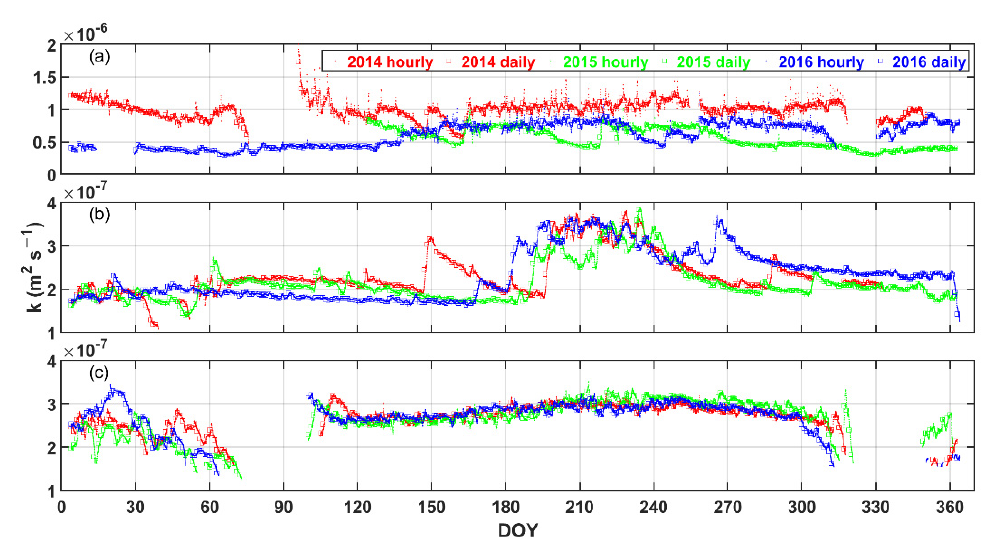
Figure 4. The variations of hourly (marked with dot) and daily (marked with square) soil apparent thermal diffusivity (k, m 2 s − 1 ) of the 0.0 m to 0.20 m layer at ( a ) BJ, ( b ) QOMS, and ( c ) NADORS for 2014–2016.